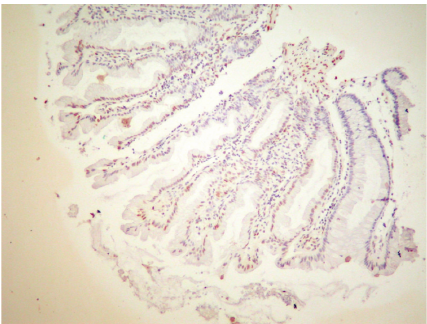
Figure 6: High-powered view of HP showing weak staining with MLH-1 protein and known MLH-1 methylation.